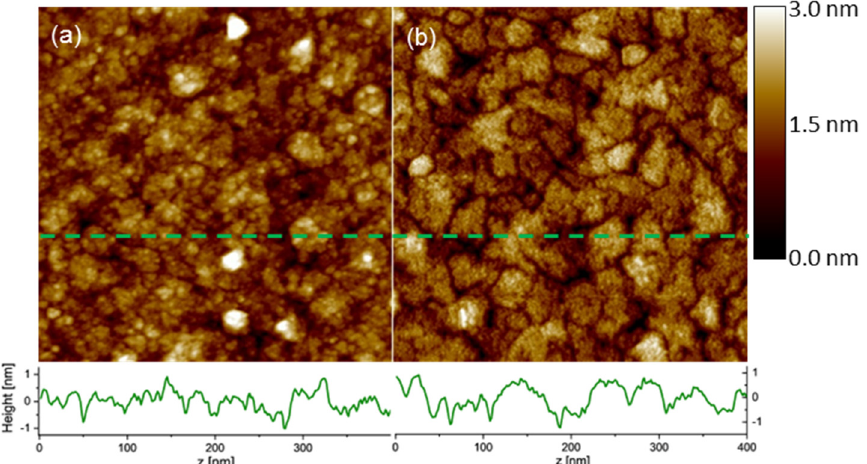
Figure 2. STM images of the 10 nm Fe 3 O 4 (111) films on MgO(111) deposited with no field ( a ) and in-field ( b ). The scan size is 400 × 400 nm 2 . The height scale is the same for both images. The plots below the STM images show the height profiles along the marked dashed lines.